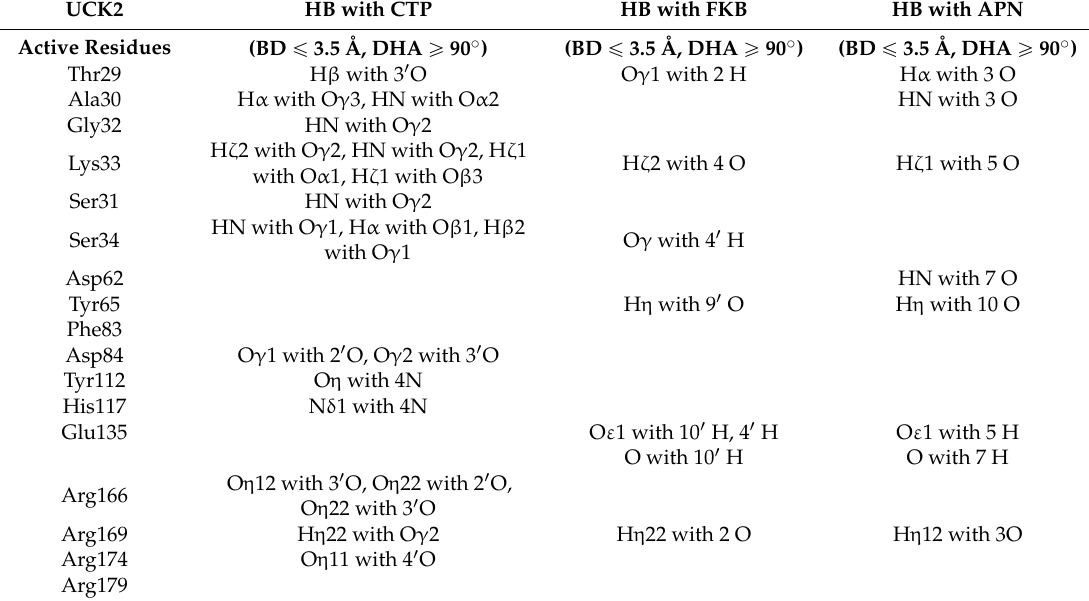
Table 2. Intermolecular hydrogen interaction between UCK2 protein and its